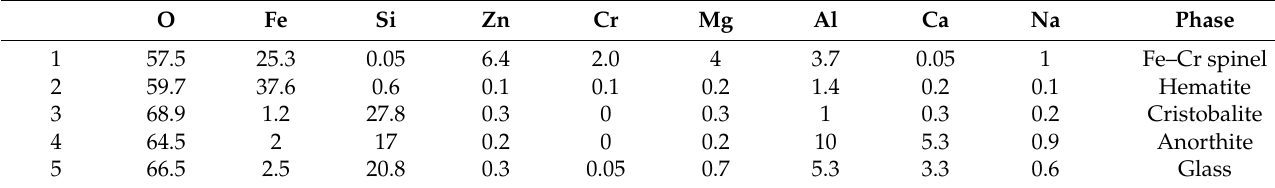
Figure 14. EDS mapping of slag 2 particles sintered at 1100 °C. Table 2. Corresponding phase components of slag 1 particles sintered at 1150 ◦ C.